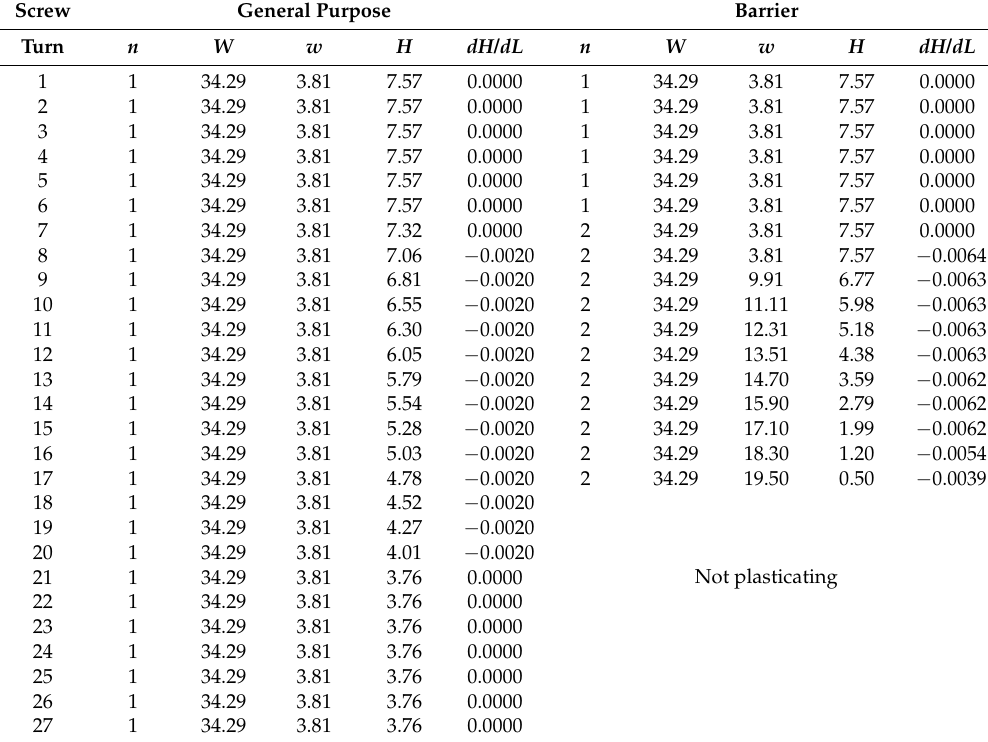
Table 1. Screw design